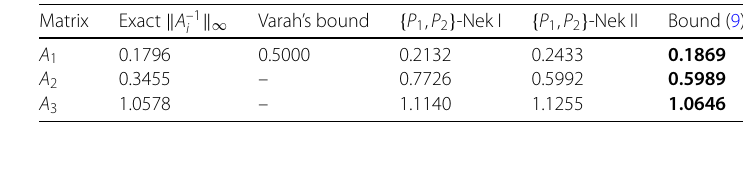
Table 1 The upper bounds for (cid:7) A –1